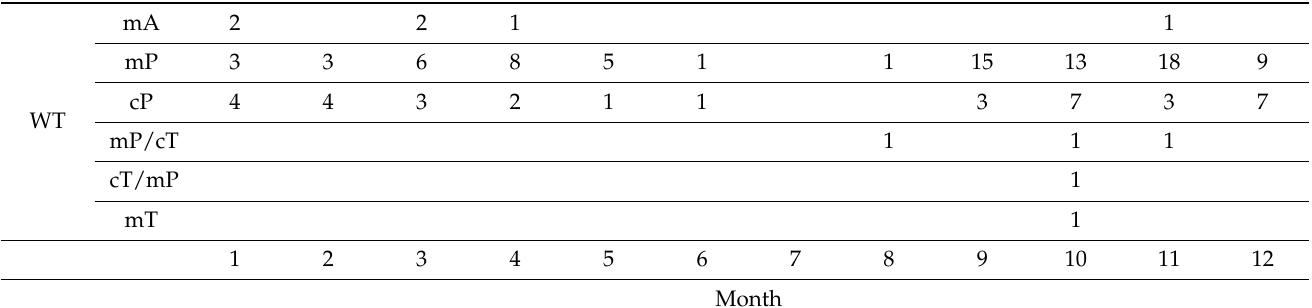
Table 6. Monthly absolute frequencies according to the classification by Olcina Cantos [14].